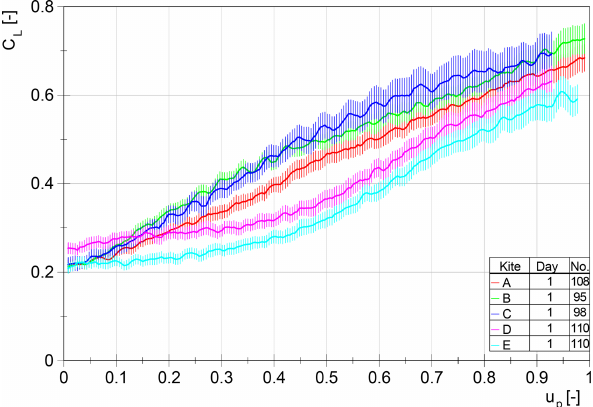
Figure 15. Lift coefficient with resulting error ( P =